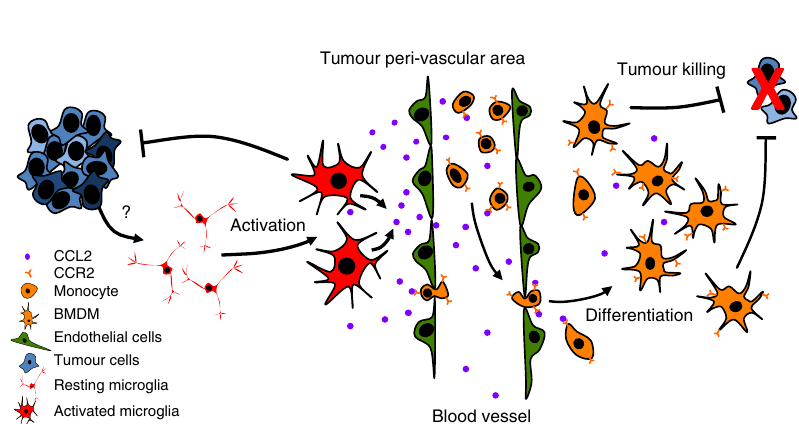
Fig. 6 Proposed mechanism of macrophage recruitment to tumour tissue. Tumour presence activates microglia, which produce CCL2 and recruit monocytes from the blood stream. Monocytes in fi ltrate tumour tissues, differentiate into macrophages, and suppress tumour cells by promoting their